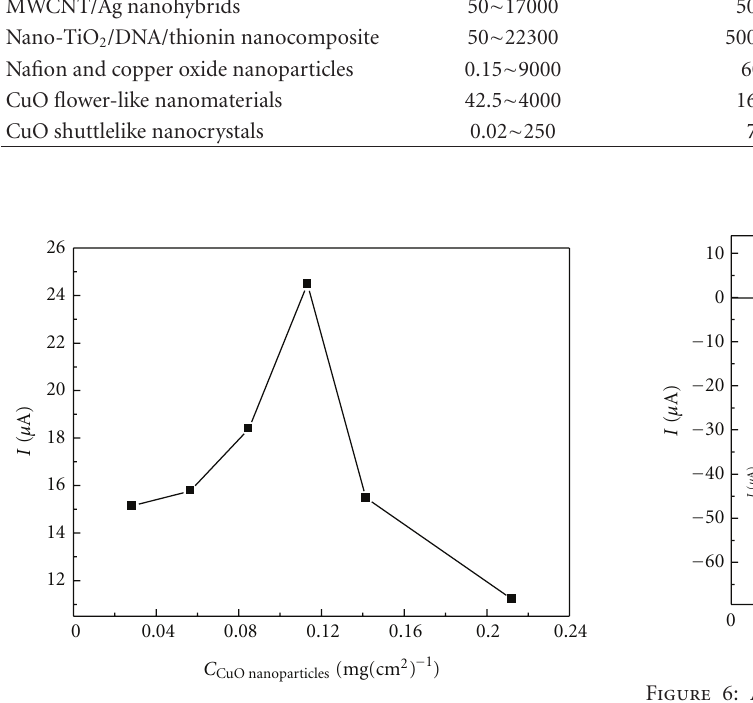
Figure 5: Current response of nano-CuO/GCE for 0.1mM H 2 O 2 inside the electrochemical reactor at various modification amounts of nano-CuO on the electrode, electrolyte: 0.01 M NaOH + 0.09 M KCl solution.